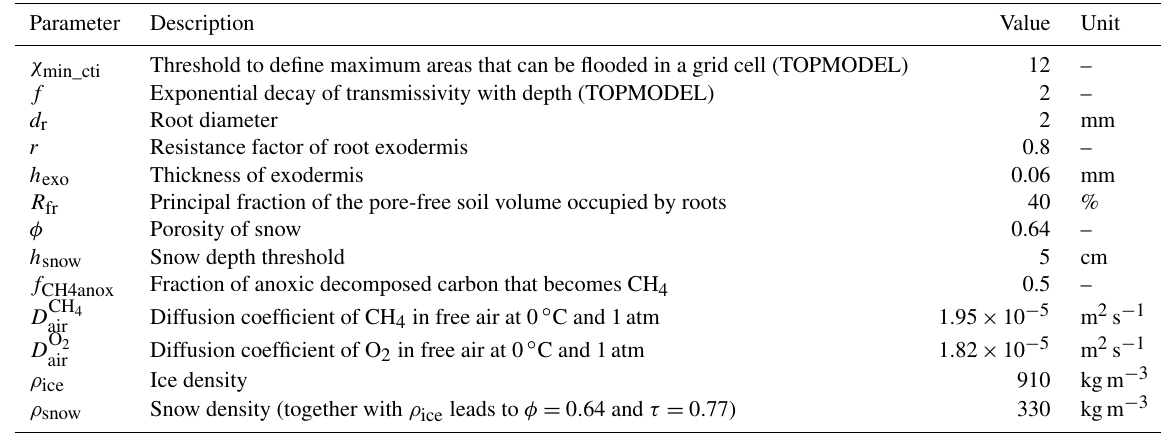
Table 1. Summary of the most relevant prescribed parameters in the JSBACH-methane control and reference simulations. Parameter